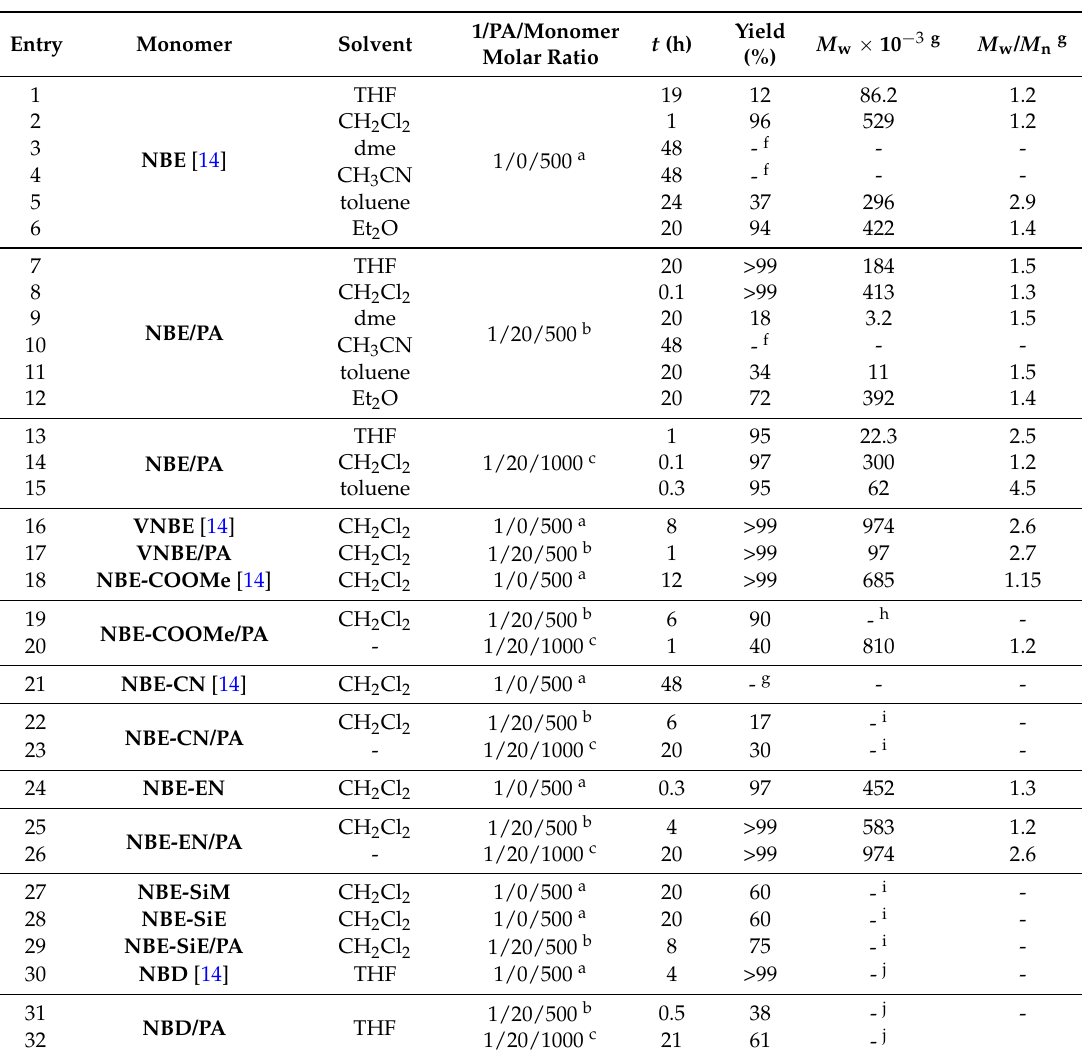
Table 1. Polymerization of cycloolefins with the catalytic systems 1 and 1 /phenylacetylene ( PA ).